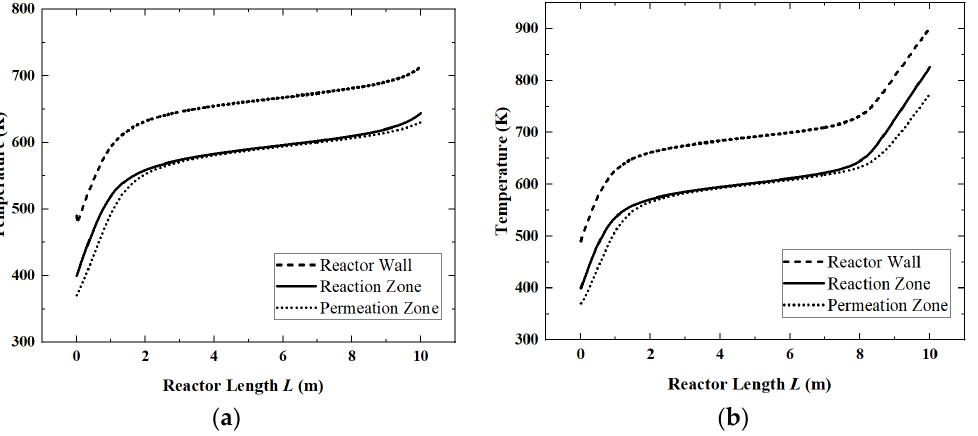
Figure 7. The temperature change of the reactor under different light intensities. ( a ) 650 W/m 2 ; ( b ) 800 W/m 2.